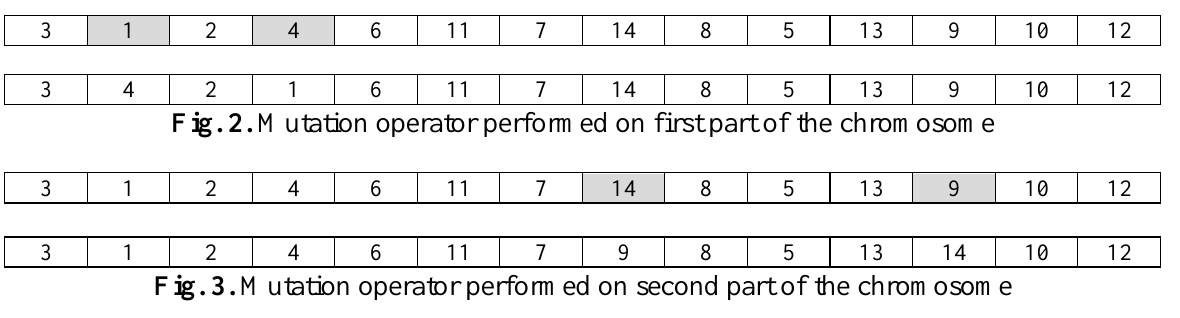
Fig. 3. Mutation operator performed on second part of the